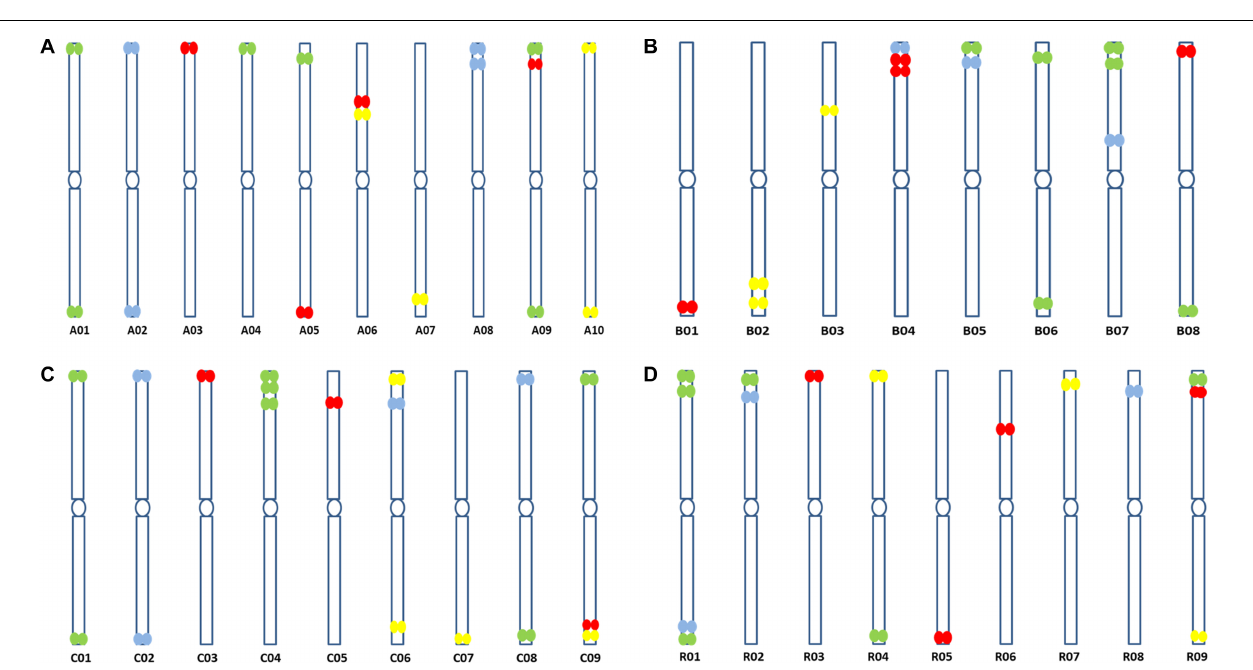
FIGURE 5 | Predicted ideotypes of (A) B. rapa (A genome, 2 n = 2 x = 20) (B) B. nigra (B genome, 2 n = 2 x = 16), (C) B. oleracea (C genome, 2 n = 2 x = 18), and (D) R. sativus (R genome, 2 n = 2 x = 18) showing sites of hybridization of the four oligonucleotide libraries (red, yellow, green, and cyan) on diagrammatic